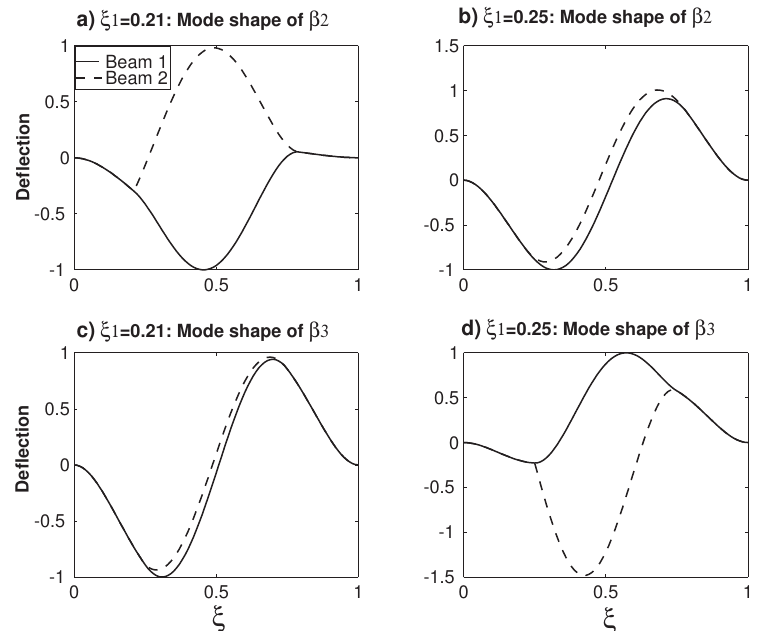
Figure 4. The changes of the mode shapes before and after a veering locus. ( a ) The β 2 mode shape at ξ 1 = 0.21 and ( b ) the β 2 mode shape at ξ 1 = 0.25. ( c ) The β 3 mode shape at ξ 1 = 0.21 and ( d ) the β 3 mode shape at ξ 1 =